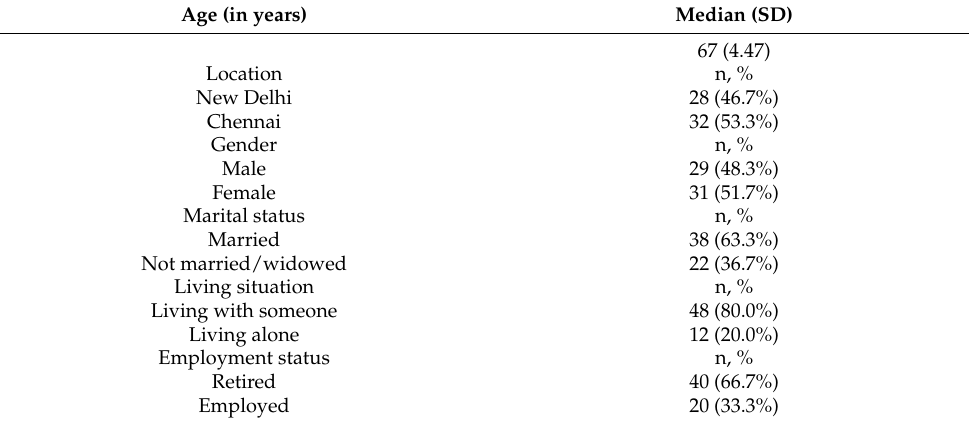
Table 1. Descriptive characteristics of study participants ( N =